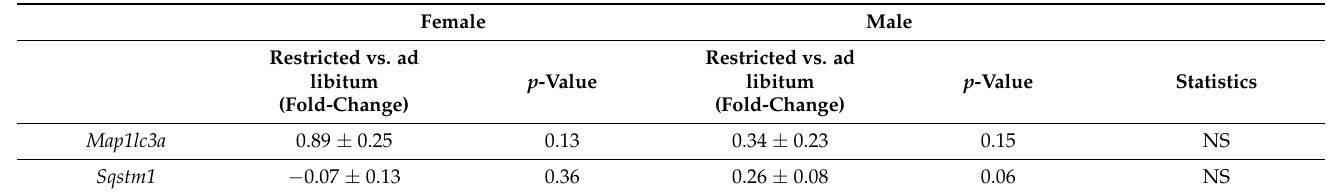
Table 5. mRNA expression levels of autophagy markers. Two-way ANOVA was performed to assess for significance. Abbreviations: NS, non-significant; Map1lc3a , microtubule-associated protein 1 light chain 3 alpha; Sqstm1 : sequestosome 1.